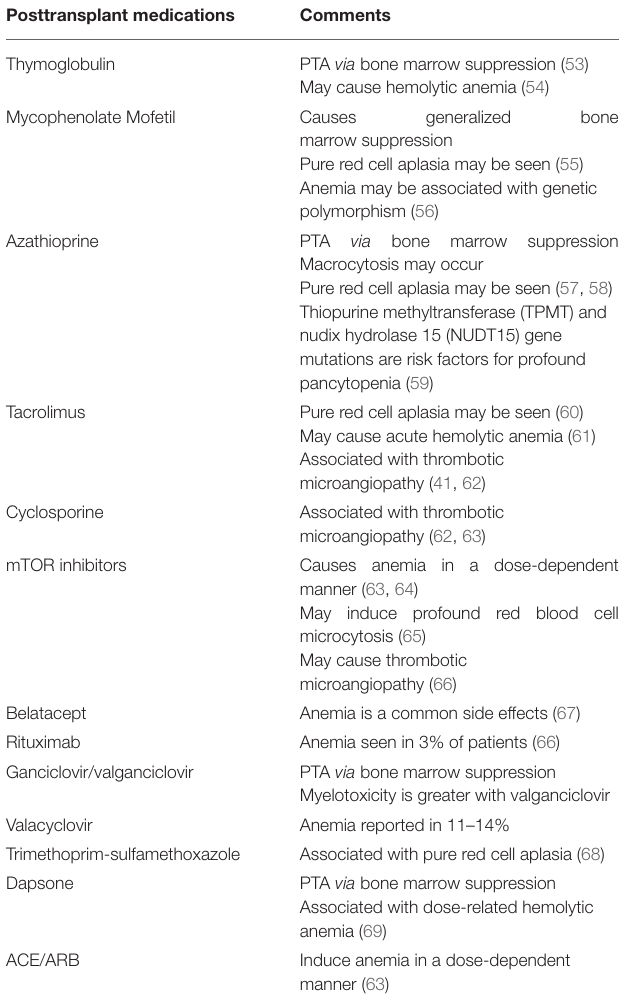
TABLE 1 | Drug-induced anemia in kidney transplant